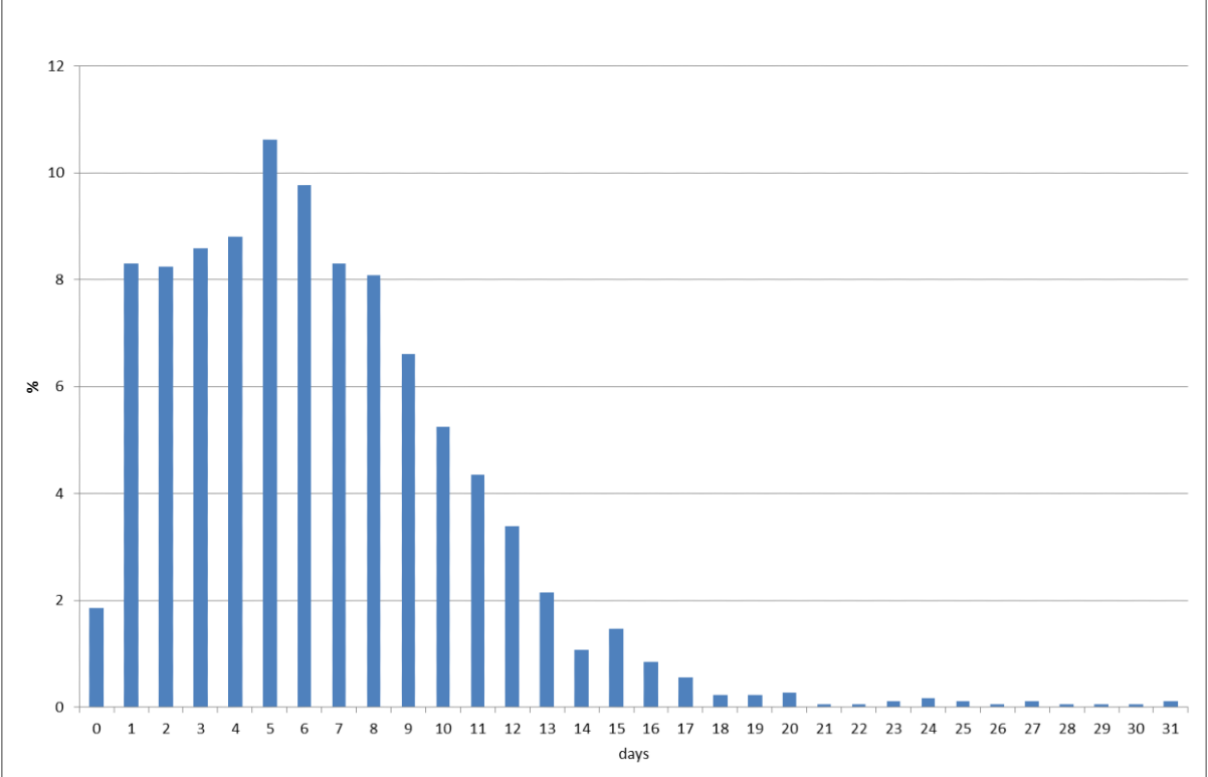
Figure 2. Empirical distribution of duration from onset to report by Ministry of Labour, Health and Welfare in Japan. Bars represent the probability of duration from onset to report based on 657 patients for whom the onset date was